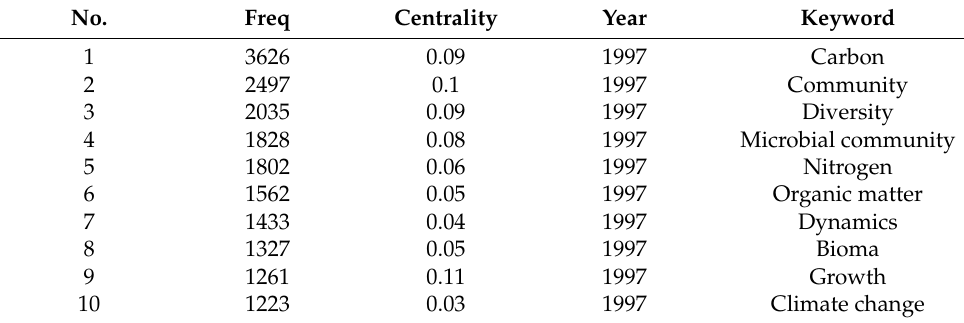
Figure 8. Clustering map of keywords of the papers on ZCC during 1997–2022. Table 9. List of keyword